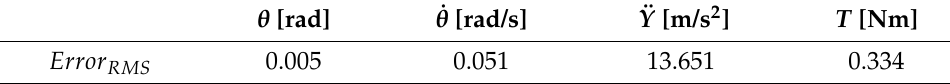
Table 3. Accuracy of the estimated quantities in terms of root mean square